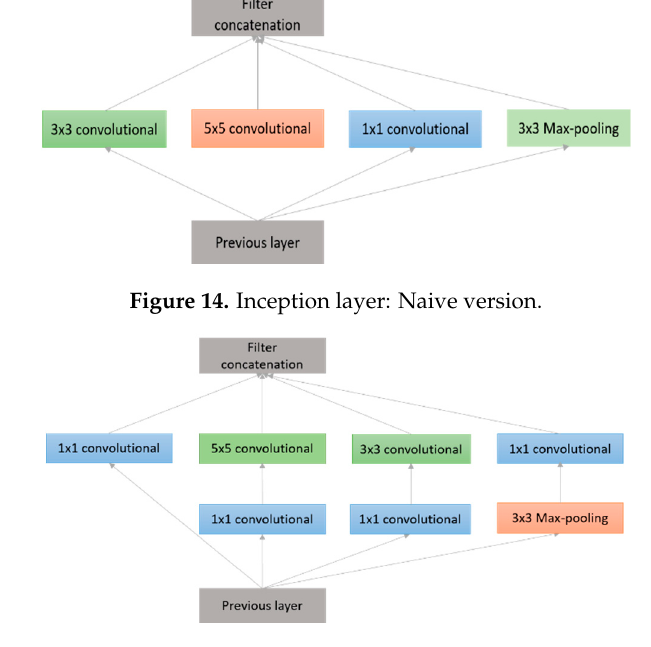
Figure 15. Inception layer with dimension reduction.